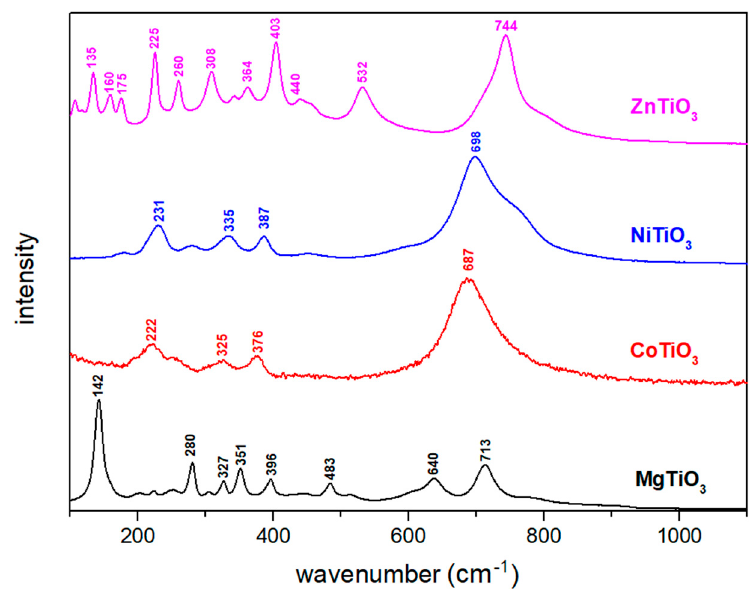
Figure 4. Raman spectra of metal titanate nanorods ATiO 3 (A = Mg, Co, Ni, Zn) after annealing process.